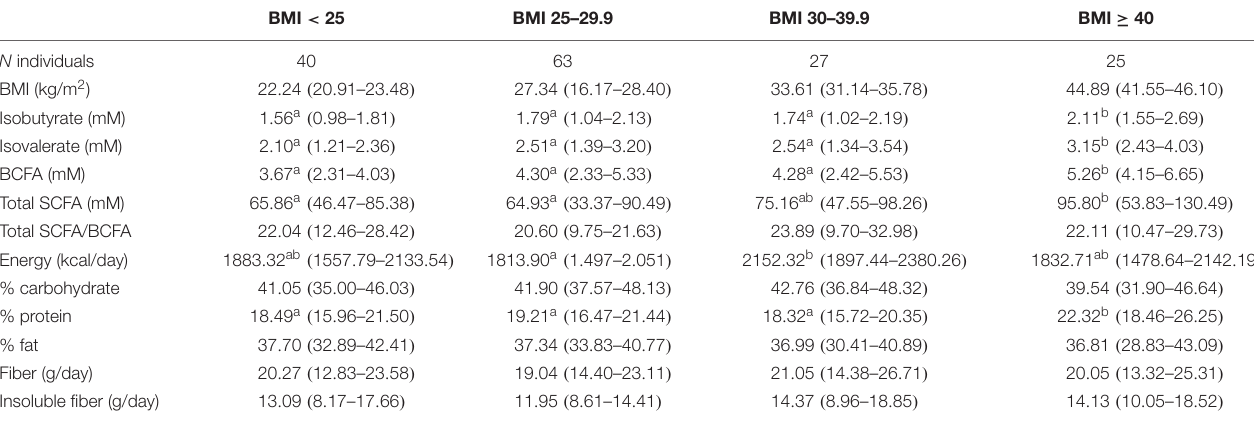
TABLE 2 | Fecal short-chain fatty acid (SCFA) levels, branched short-chain fatty acids (BCFA), and total SCFA/BCFA ratio, as well as general characteristics and daily dietary intakes of the studied population along the different BMI